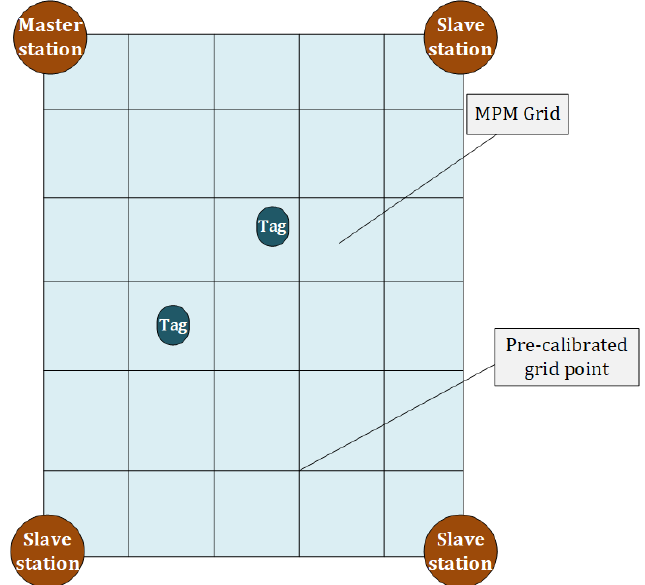
Figure 2. Rudiment of Multi-Path Map